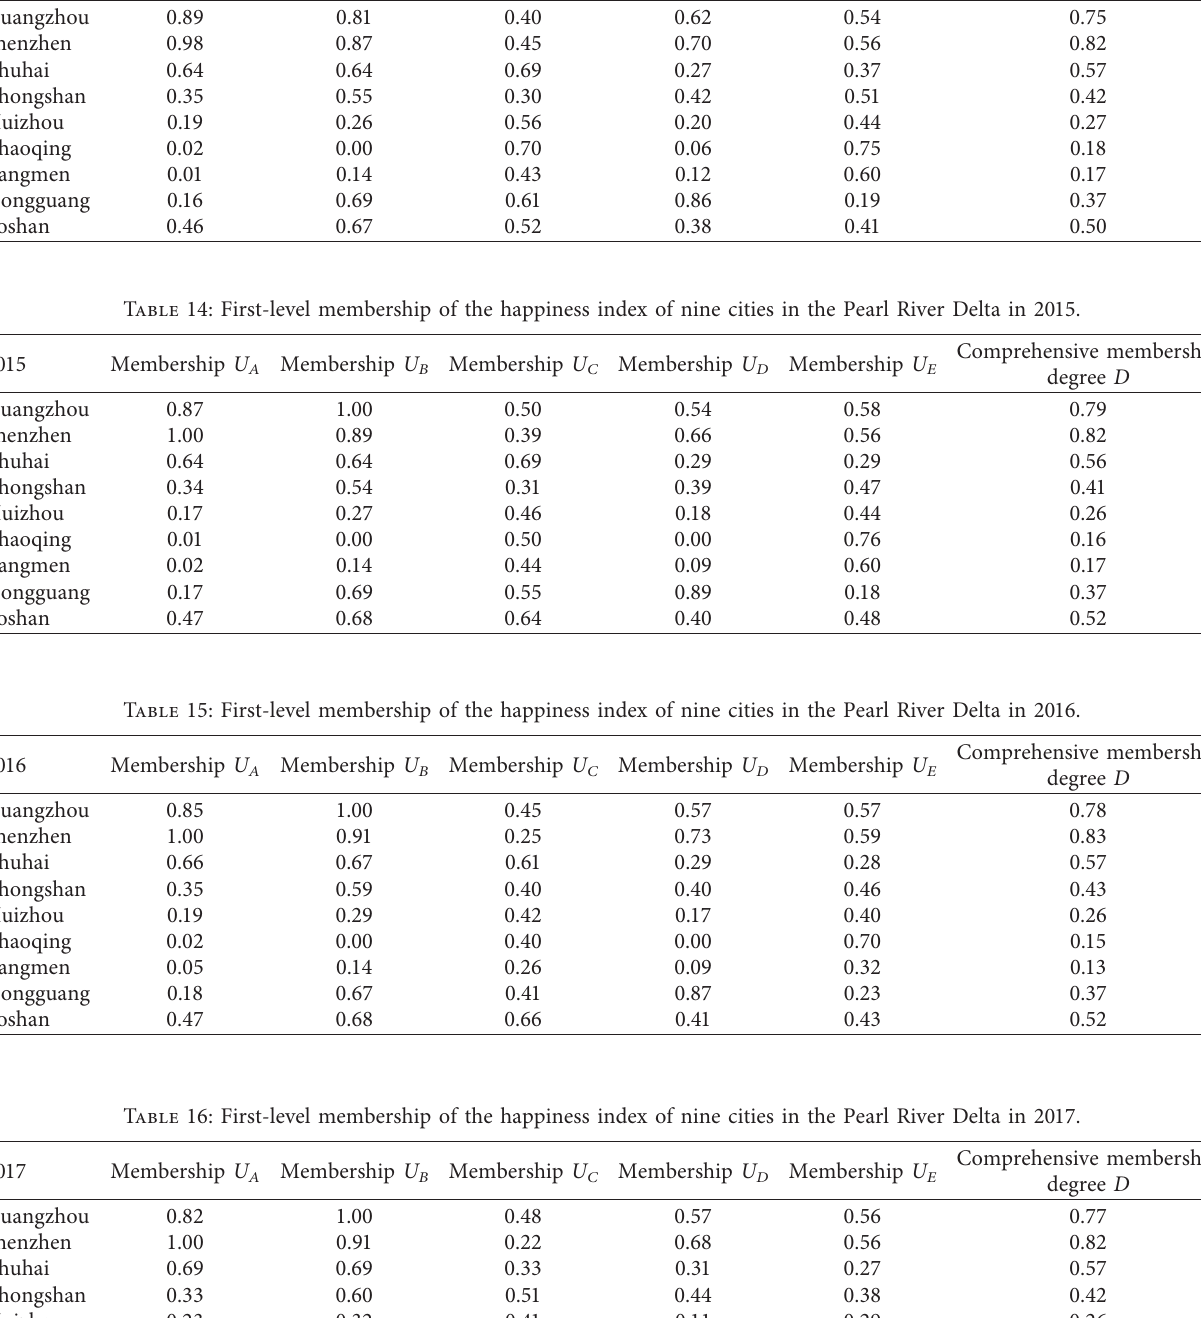
Table 13: First-level membership of the happiness index of nine cities in the Pearl River Delta in 2014. 2014